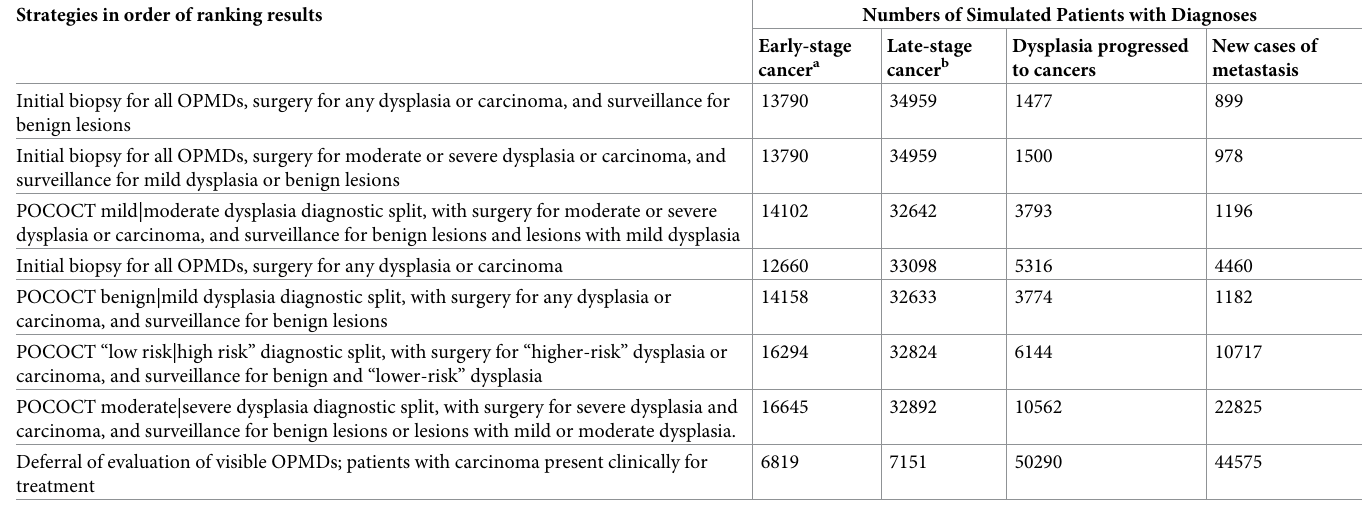
Table 4. Numbers of carcinomas over remaining lifetime in one million simulated 60-year-old men with OPMDs (using base case estimates for model parameters). Strategies in order of ranking